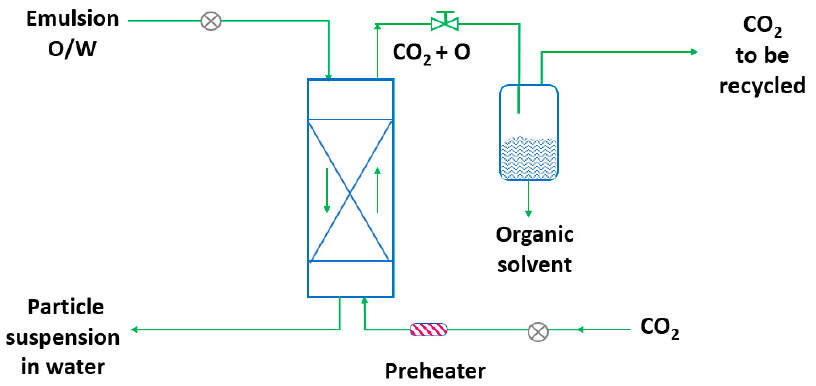
Figure 14. Supercritical Fluid Extraction of Emulsions (SFEE) process (adapted from Prieto et al. [185]).